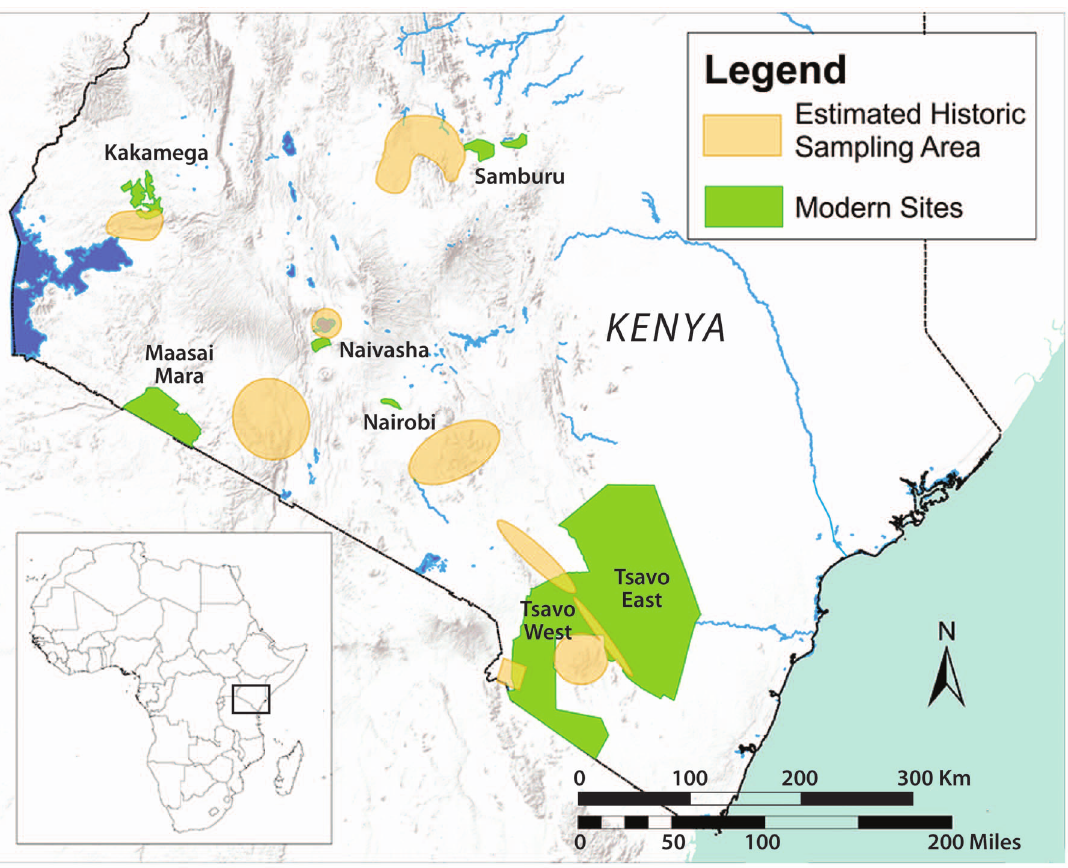
Figure 1. Study area. Map of modern sites with estimated areas of historical sampling superimposed (see Appendix C 2.1 in File S2 for more information). GIS data from WRI [41].